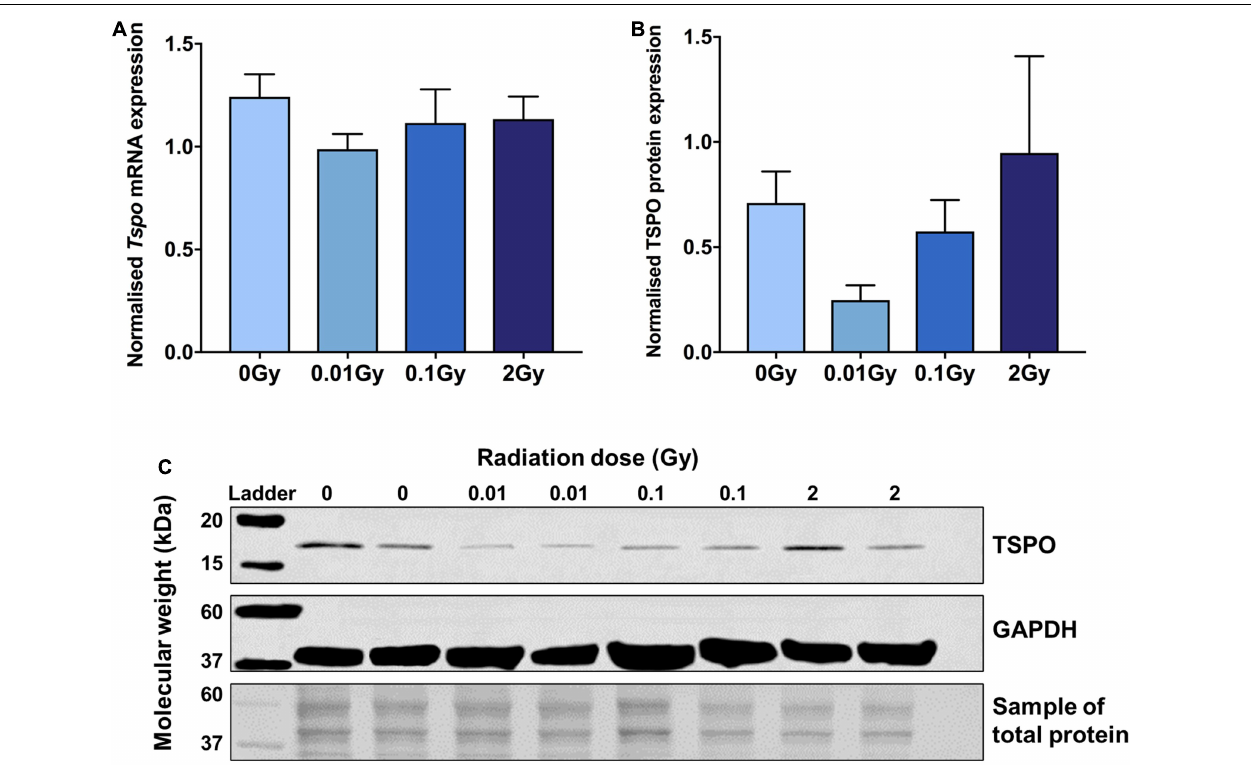
FIGURE 1 | TSPO protein and mRNA expression in brain tissue following whole body gamma irradiation demonstrates a downregulation after 0.01 Gy exposure. (A) Tspo mRNA expression (normalized to Gapdh and Actin ) decreased after 0.01 Gy whole body irradiation compared to control, though did not reach statistical significance ( p > 0.05). (B,C) Western blotting (normalized to total protein concentration) confirmed a downregulation in TSPO protein expression after 0.01 Gy irradiation, but also did not reach significance ( p > 0.05). Blot images have been merged using bands from different membranes. Whilst the entire membrane was used for total protein normalization, only a section of the membrane is displayed in this image. Data are presented as mean and standard error, n =